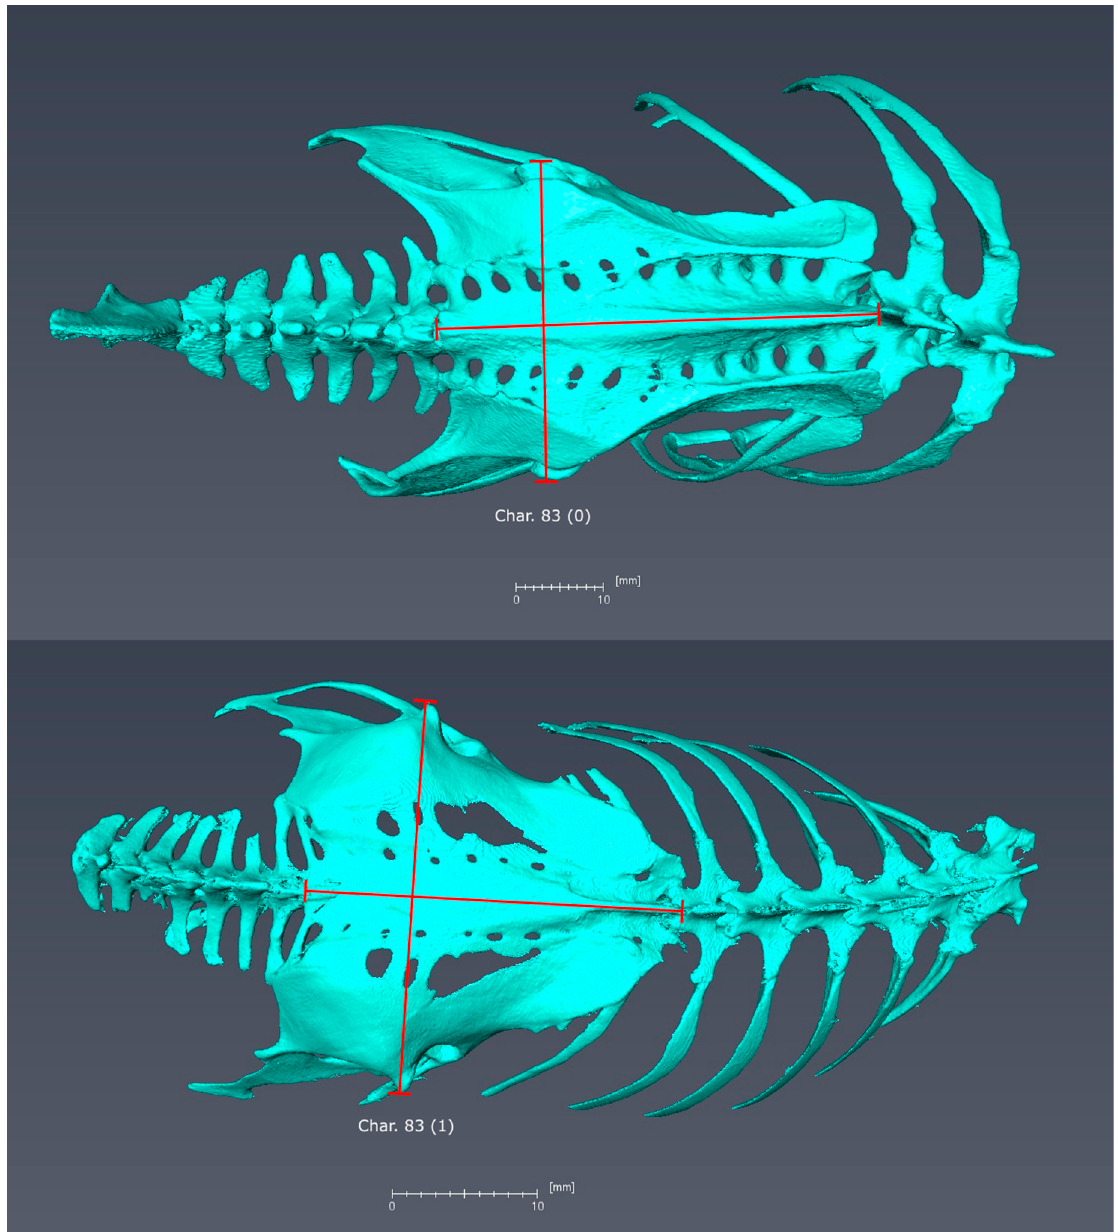
Figure A2. Synsacra of Podargus strigoides (top) and Streptoprocne zonaris (bottom) in dorsal view. Podargus exhibits state 0 for character 83 (pelvis width across antitrochanters less than length of synsacrum), whereas Streptoprocne exhibits state 1 (pelvis width across antitrochanters greater than length of synsacrum, optimized as a synapomorphy of Daedalornithes as well as Caprimulgiformes).